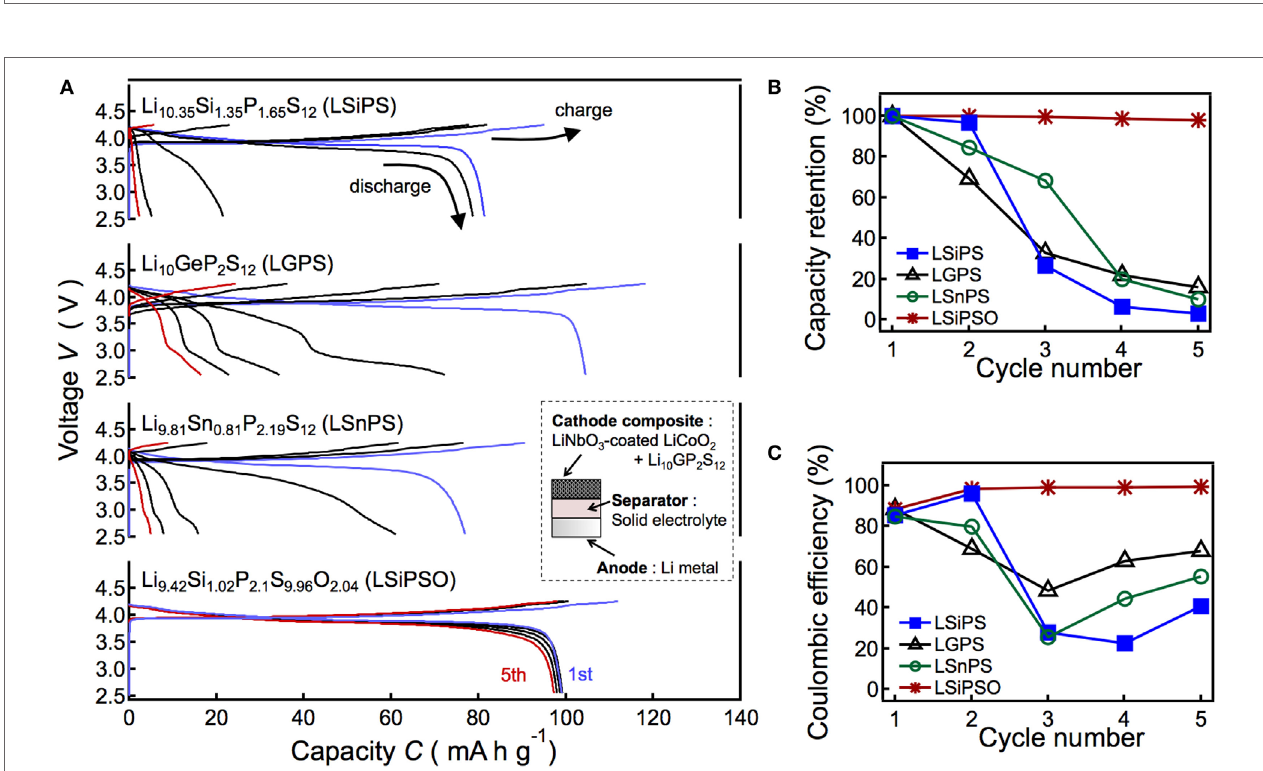
FigUre 4 | results of the charge/discharge tests of the all-solid-state cell consisting of a linbO 2 -coated licoO 2 cathode, li 9.42 si 1.02 P 2.1 s 9.96 O 2.04 (lsiPsO) as the electrolyte, and a li metal anode . The figure also shows the data for cells with Si-, Sn-, and Ge-based LGPS-type solid electrolytes as the separator. The left panel shows charge–discharge curves (a) and right panels show the capacity retention (b) and coulombic efficiency (c) as functions of the cycle number.